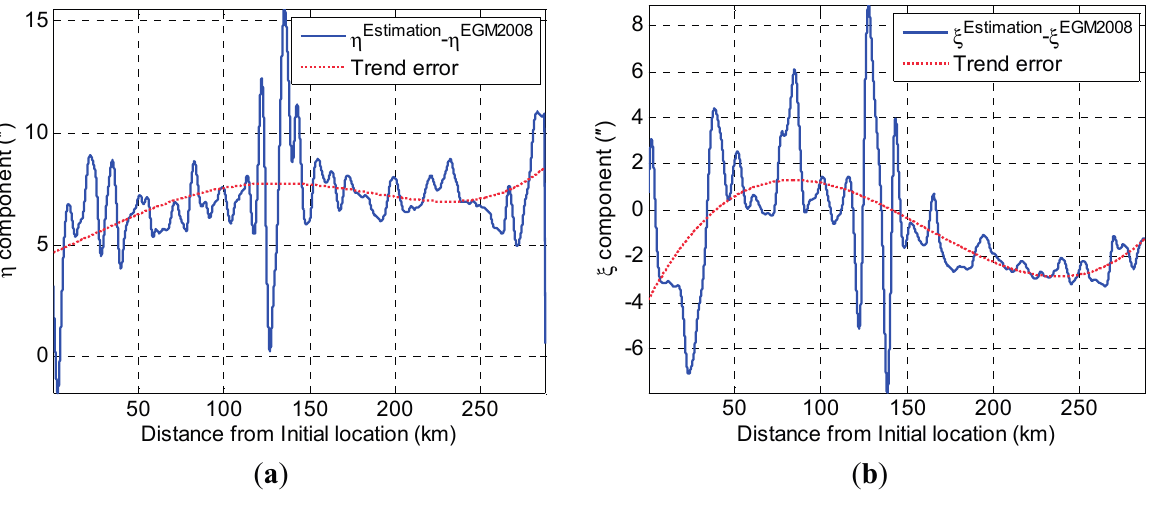
Figure 13. ( a ) Trend error correction for η ; ( b ) trend error correction for ξ .